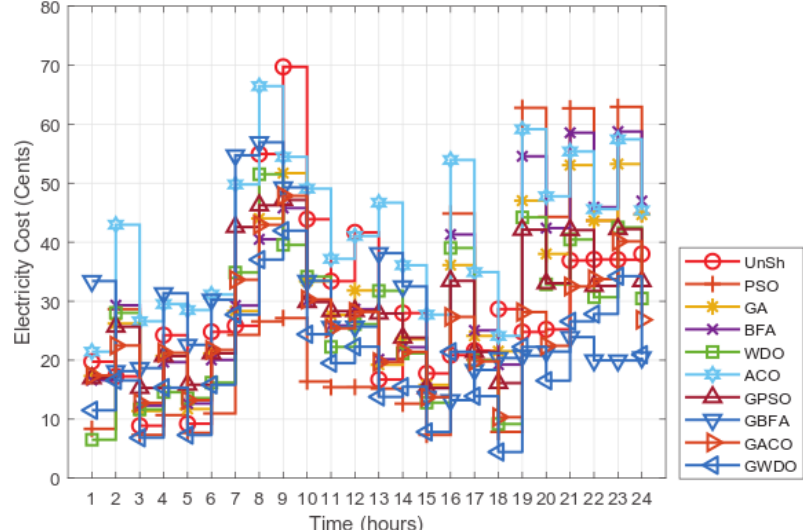
Figure 5. Case study 1: Electricity cost reduction.